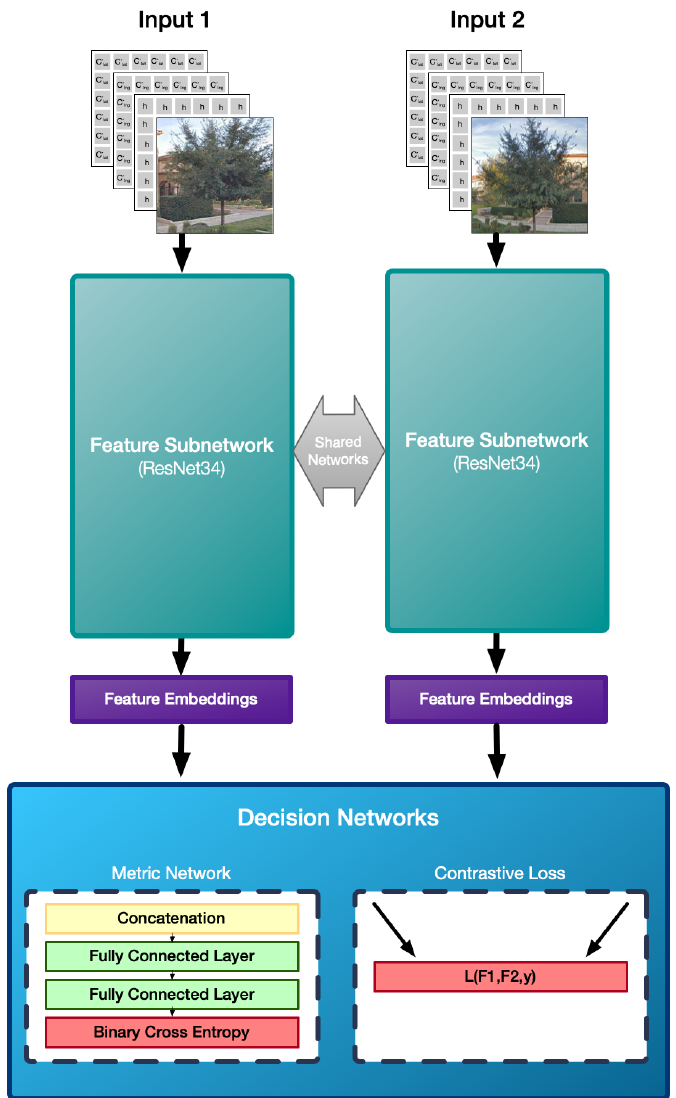
Figure 4. Diagram showing the overall network architecture. The Feature Subnetwork receives an image with three extra channels ( { [ C ∗ , C ∗ , h ◦ ] } ) as input (shown as three additional matrix layers in lat lng grey). In general, the feature subnetworks could be of any state-of-the-art architecture but preliminary tests showed that ResNet consistently yielded best performance. Generated feature embeddings are passed to the decision networks that classify whether two image patches are matching or